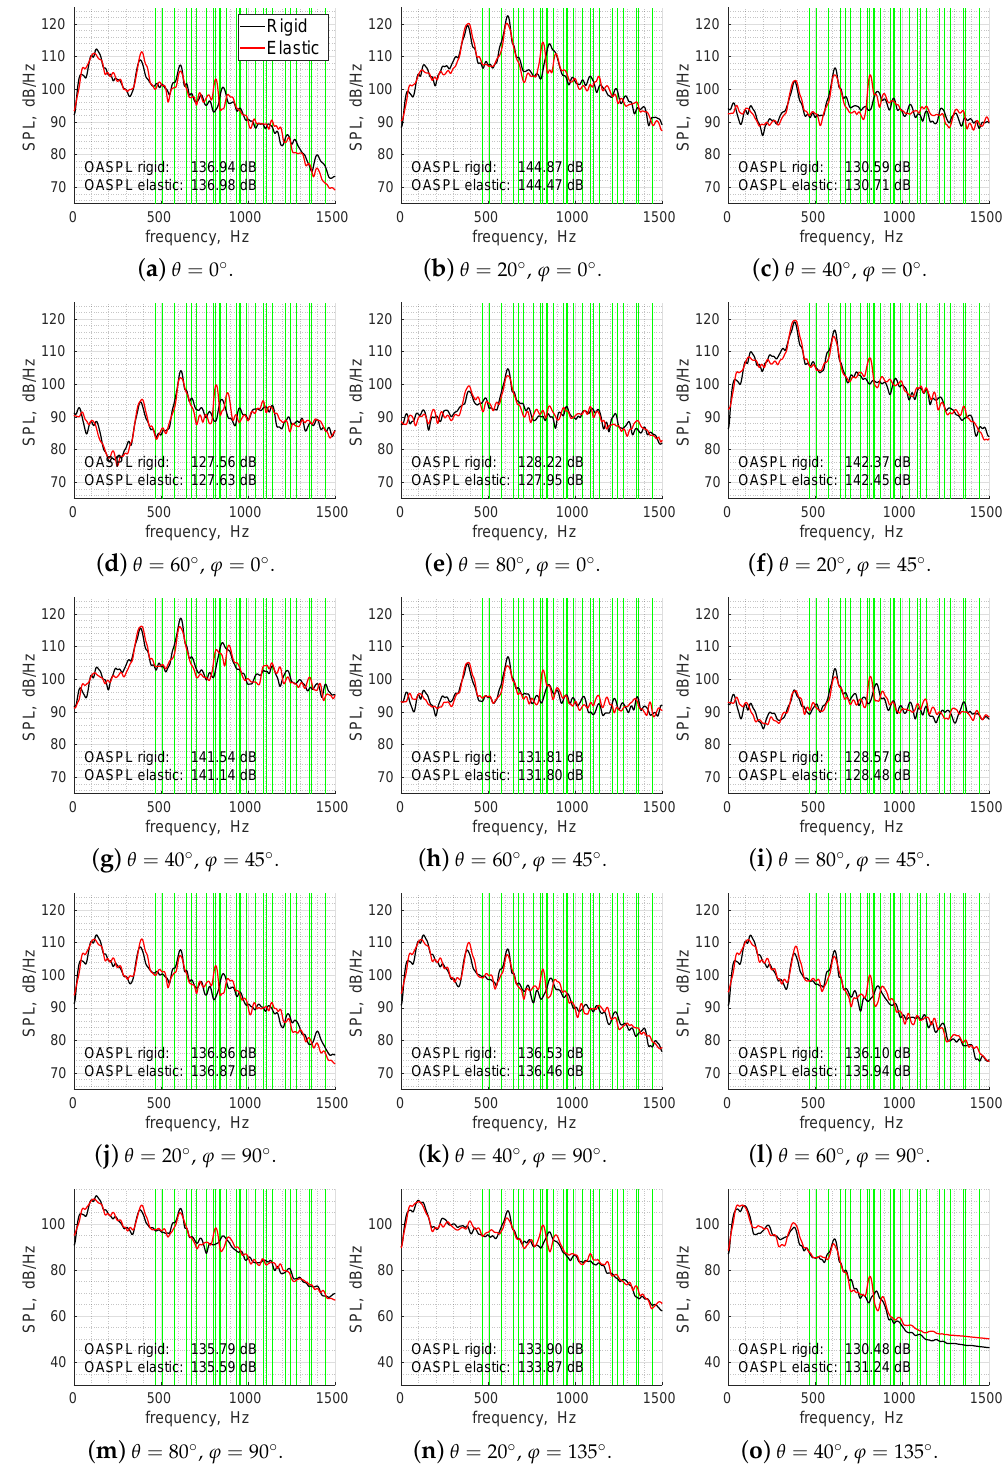
Figure 14. SPL and OASPL at the microphones. Green vertical lines mark the structural eigenfre-